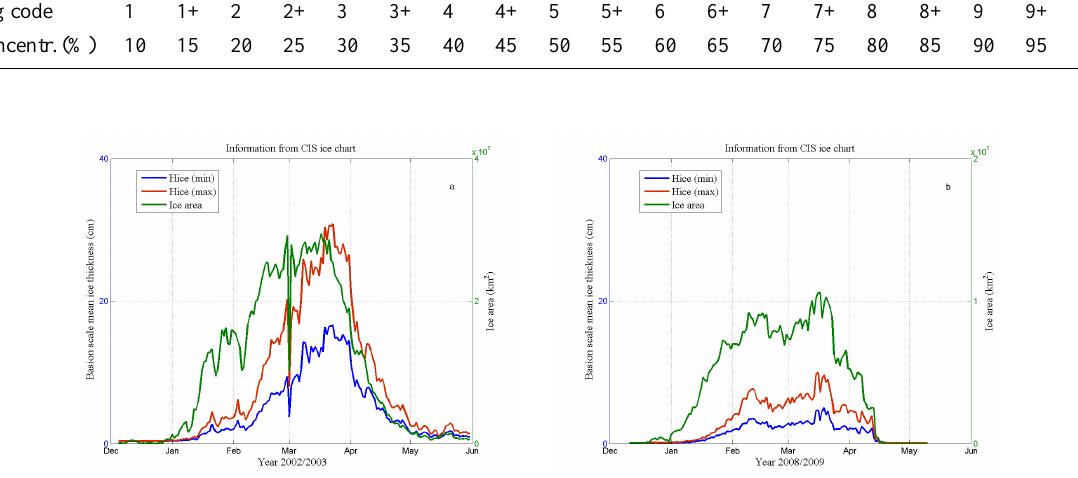
Fig. 3. Time series of daily basin-scale minimum and maximum ice thickness and ice area retrieved from operational CIS ice charts for winters (a) 2002–2003 and (b) 2008–2009. The CIS ice chart gives a range for the daily minimum ice thickness in the domain (see Fig. 1) and another range for the maximum. The minimum and maximum thicknesses are the means of these ranges. The ice area is the total ice-covered area in the domain.